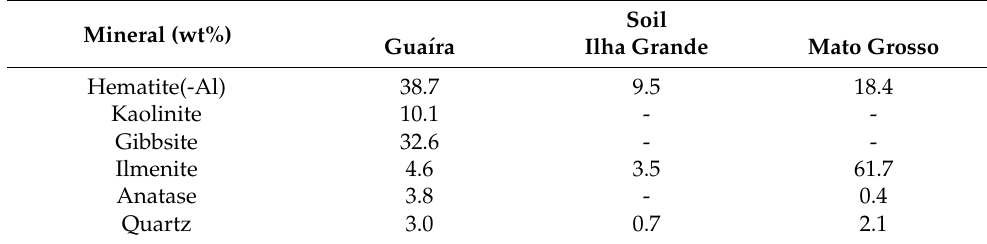
Table 3. Rietveld quantitative phase analysis, substitutions, and magnetite stoichiometry ( χ ) for the